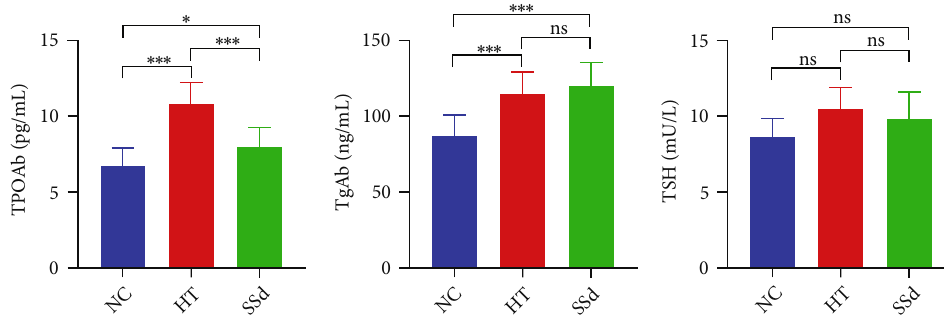
Figure 7: Serum TPOAb, TgAb, and TSH concentrations in mice ( ∗∗∗ P < 0 : 001 ).